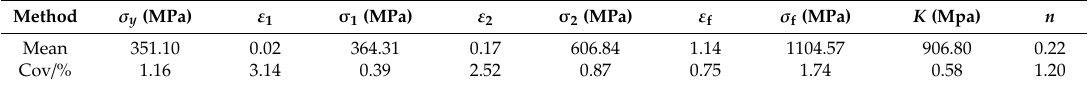
Figure 2. Calibrated true stress–plastic-strain curve. Table 2. Constitutive model parameters under tensile loading.